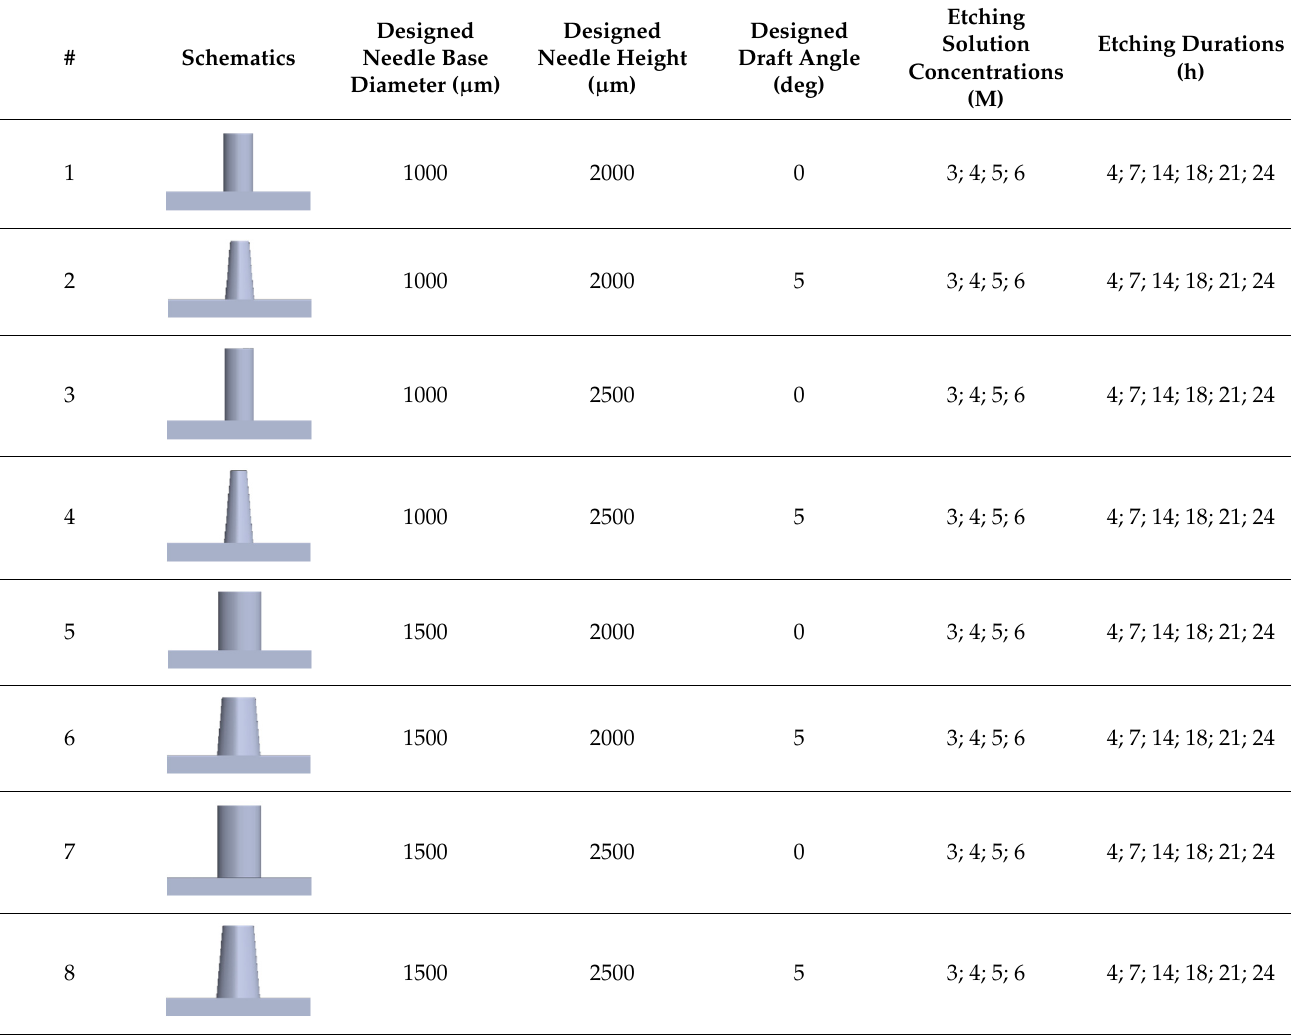
Table 1. Geometrical parameters (needle base diameter, needle height, and draft angle) used to design various shapes of MNs, manufactured by 3D printing, followed by etching experiment with the presented criteria.